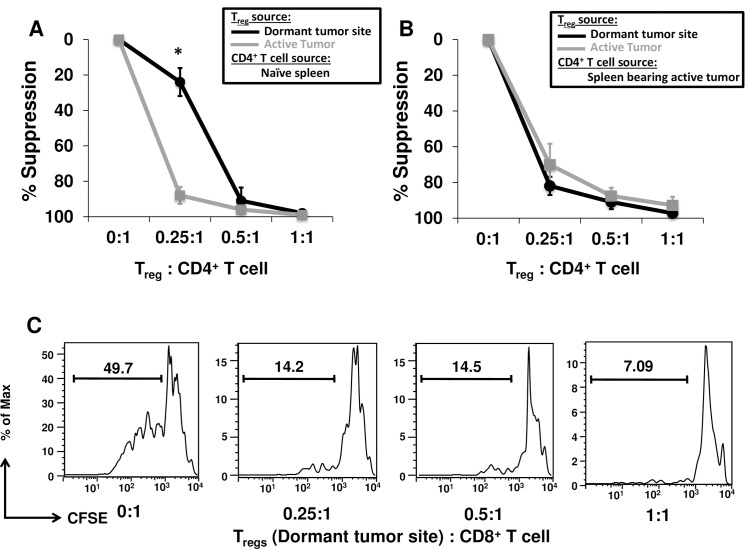
Tregs from the dormant BCL1 tumor microenvironment maintain their capacity to suppress CD4+ and CD8+ T cells.Treg suppression assays were performed using CD4+ T cells purified from spleens of (A) naive mice, or (B) BCL1 tumor-inoculated mice. Suppression by Tregs was calculated relative to the samples containing CD4+T cells only (0:1). The data are shown as mean ± SEM from three experiments (* p < 0.05). (C) Tregs were sorted from spleens of mice harboring dormant BCL1 tumor cells and co-cultured with CFSE-labeled CD8+T cells purified from naive mice. Histogram plots are gated on CD8+ cells and the values represent the percent CFSE dilution. Representative plots of 3 independent experiments yielding similar results.